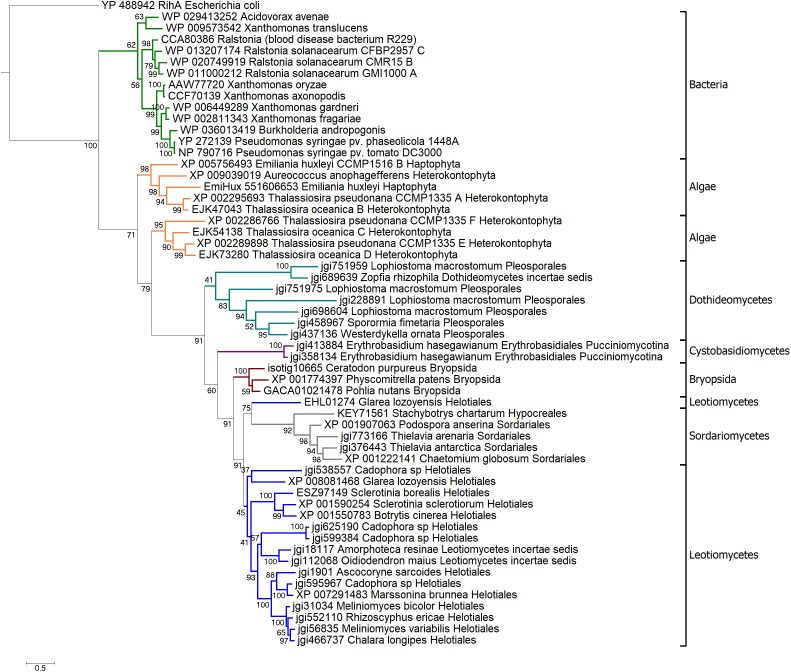
Bayesian phylogenetic tree of HLPs. The tree was rooted with classical nucleoside hydrolase RihA from Escherichia coli. Branches representing main taxa were highlighted: bacteria in green, algae in orange, Dothideomycetes in teal, Sordariomycetes in gray, Cystobasidiomycetes in purple, mosses in brown, Leotiomycetes in navy. Each taxon is marked with black bracket. The analysis was carried out in PhyloBayes-MPI v. 1.5 (Lartillot et al., 2009). Three chains of 40000 iterations were run in parallel, two chains of best convergence were chosen for the consensus tree construction.